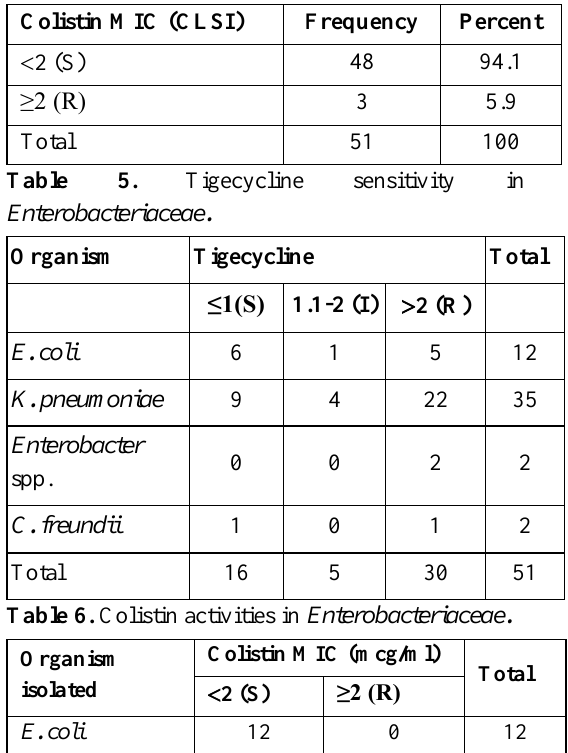
Table 4. Colistin sensitivity pattern according to EUCAST guidelines.